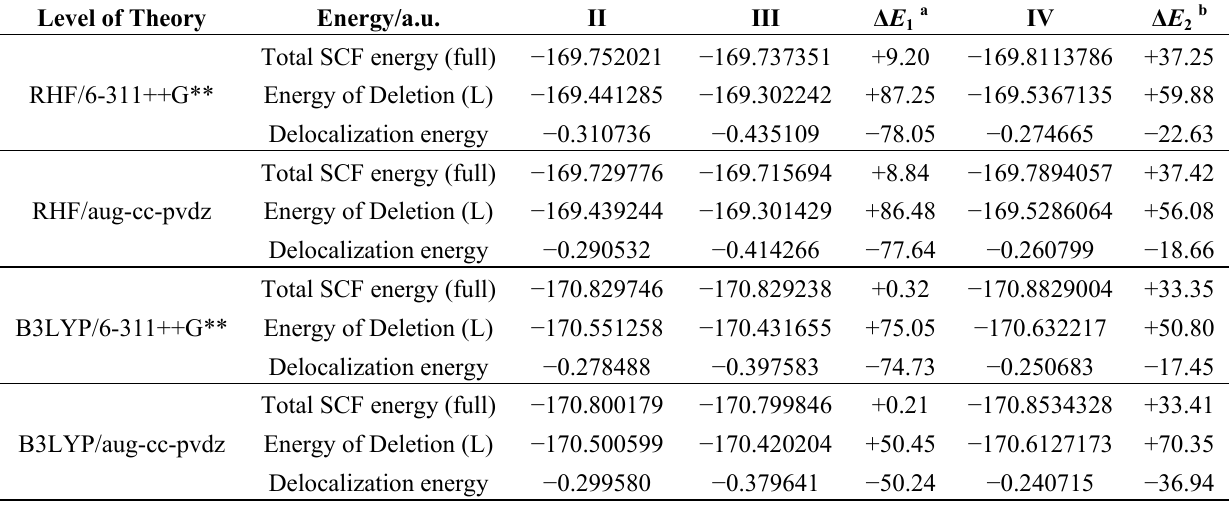
Table 8. NBO analyses of the total SCF, deletion and delocalization energies (a.u.) of Z-prop-2-ynylidemeamine (II), prop-1,2-diene-1-imine (III) and vinyl cyanide (IV)